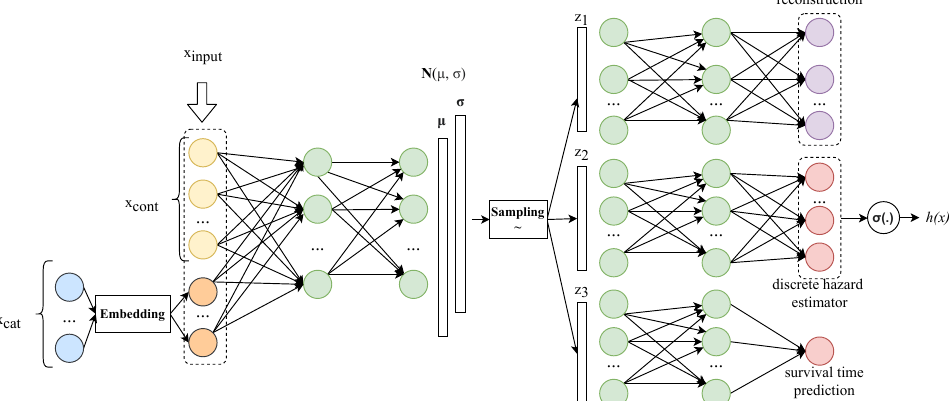
Figure 1. VAE multiple task network architecture with one encoder and three decoders; z 1 z 2 and z 3 are independent samples from the distribution of N ( µ , σ 2 ) . h ( x ) hazard function of the input x org